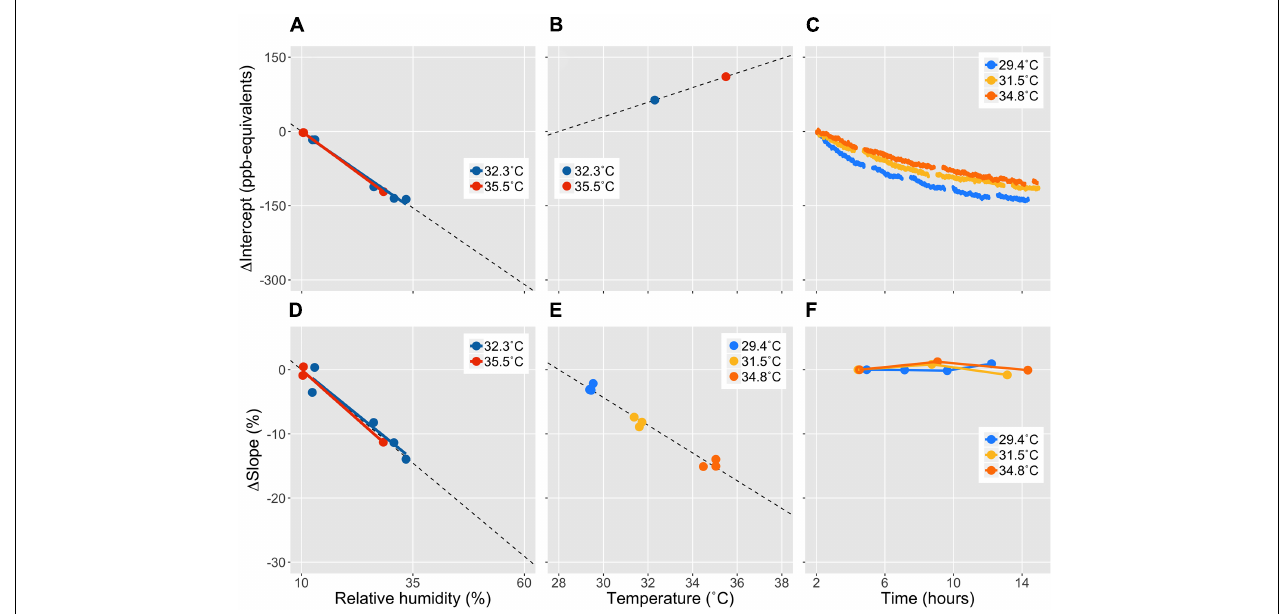
FIGURE 2 | Sensitivity of PID calibration intercept (baseline signal) and slope (responsivity to isobutylene gas) to relative humidity, temperature, and time. To isolate each effect, the results in each panel are expressed as deltas relative to a common reference point. To compare the effect sizes of the different mechanisms of measurement error, the data are plotted across a typical range of diurnal variation of relative humidity (RH, 50%) and air temperature (T, 10 ◦ C) experienced during outdoor sampling. The negative sensitivity of the calibration intercept to RH (A) is about twice as strong as its positive sensitivity to T (B) and negative sensitivity to operation time (C) over the representative diurnal ranges. The negative sensitivity of the calibration slope to RH (D) is about 1.5 times the negative sensitivity to T (E) over the specified ranges, while no temporal drift was detected (F) . We found no interactive effects between T and RH (A,D) . To remove the effect of variable RH during T-sensitivity experiments, the calibration coefficients from (B,E) were adjusted to represent a common RH based on (A,D) . Intercepts (A,B) were corrected for temporal drift (C) , while the slopes in (E) are derived from three full-day experiments at different temperatures (F) .